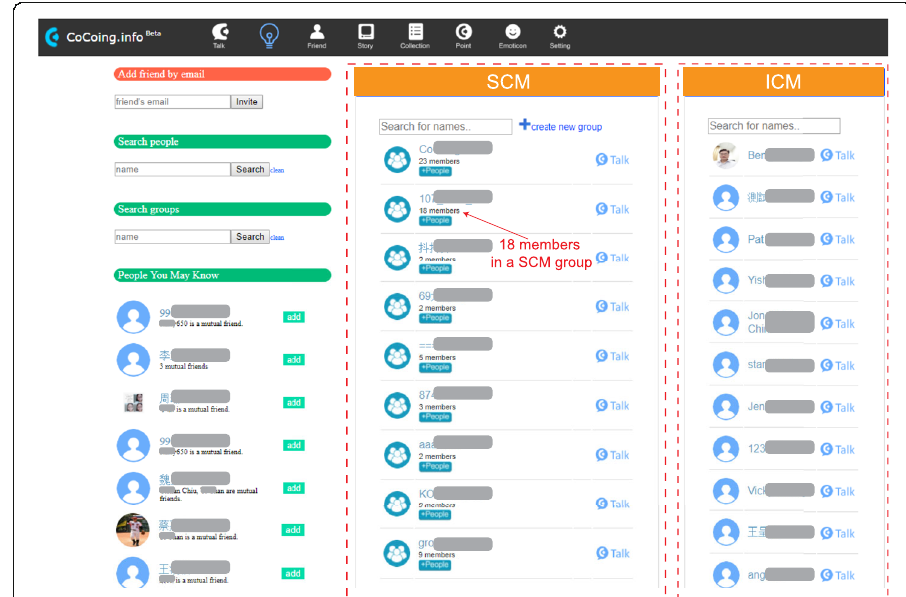
Fig. 2 Social network building